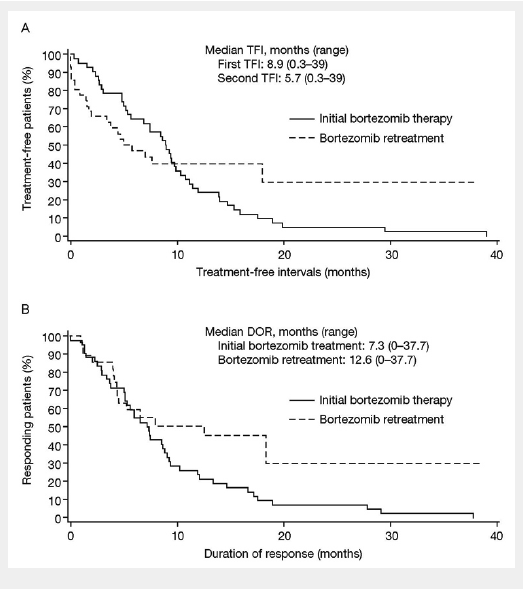
Figure 1 Bortezomib treatment-free interval (A), duration of response